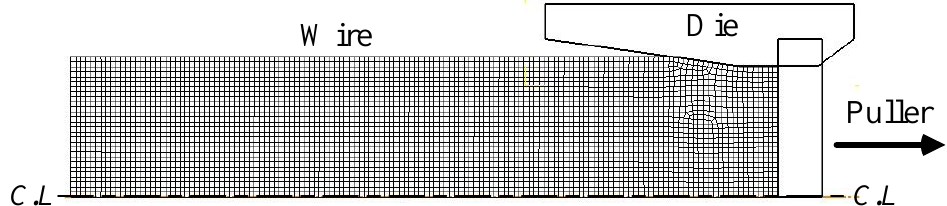
Figure 4. Initial model of the elastic–plastic analysis.